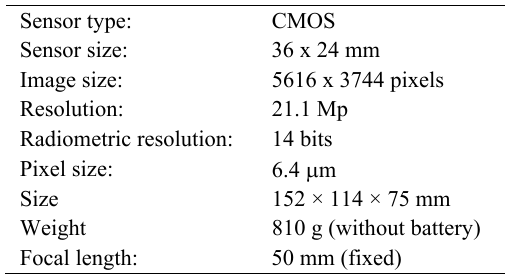
Table 3. Technical specifications of the full-frame camera, Canon 5D MkII.